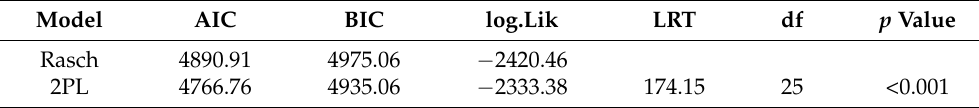
Table 5. Model comparison: Rasch and